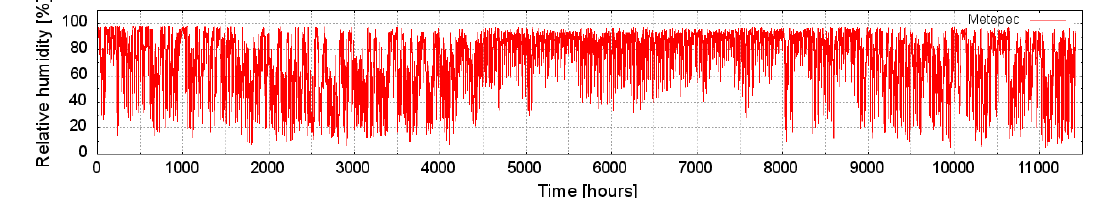
Figure 6. Relative humidity time series from Metepec, Hidalgo (ten-minute averages).